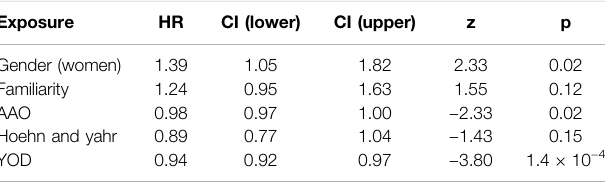
TABLE 2 | Results of the stepwise multivariable Cox PH regression modeling LID onset vs non-genetic factors. Exposure HR